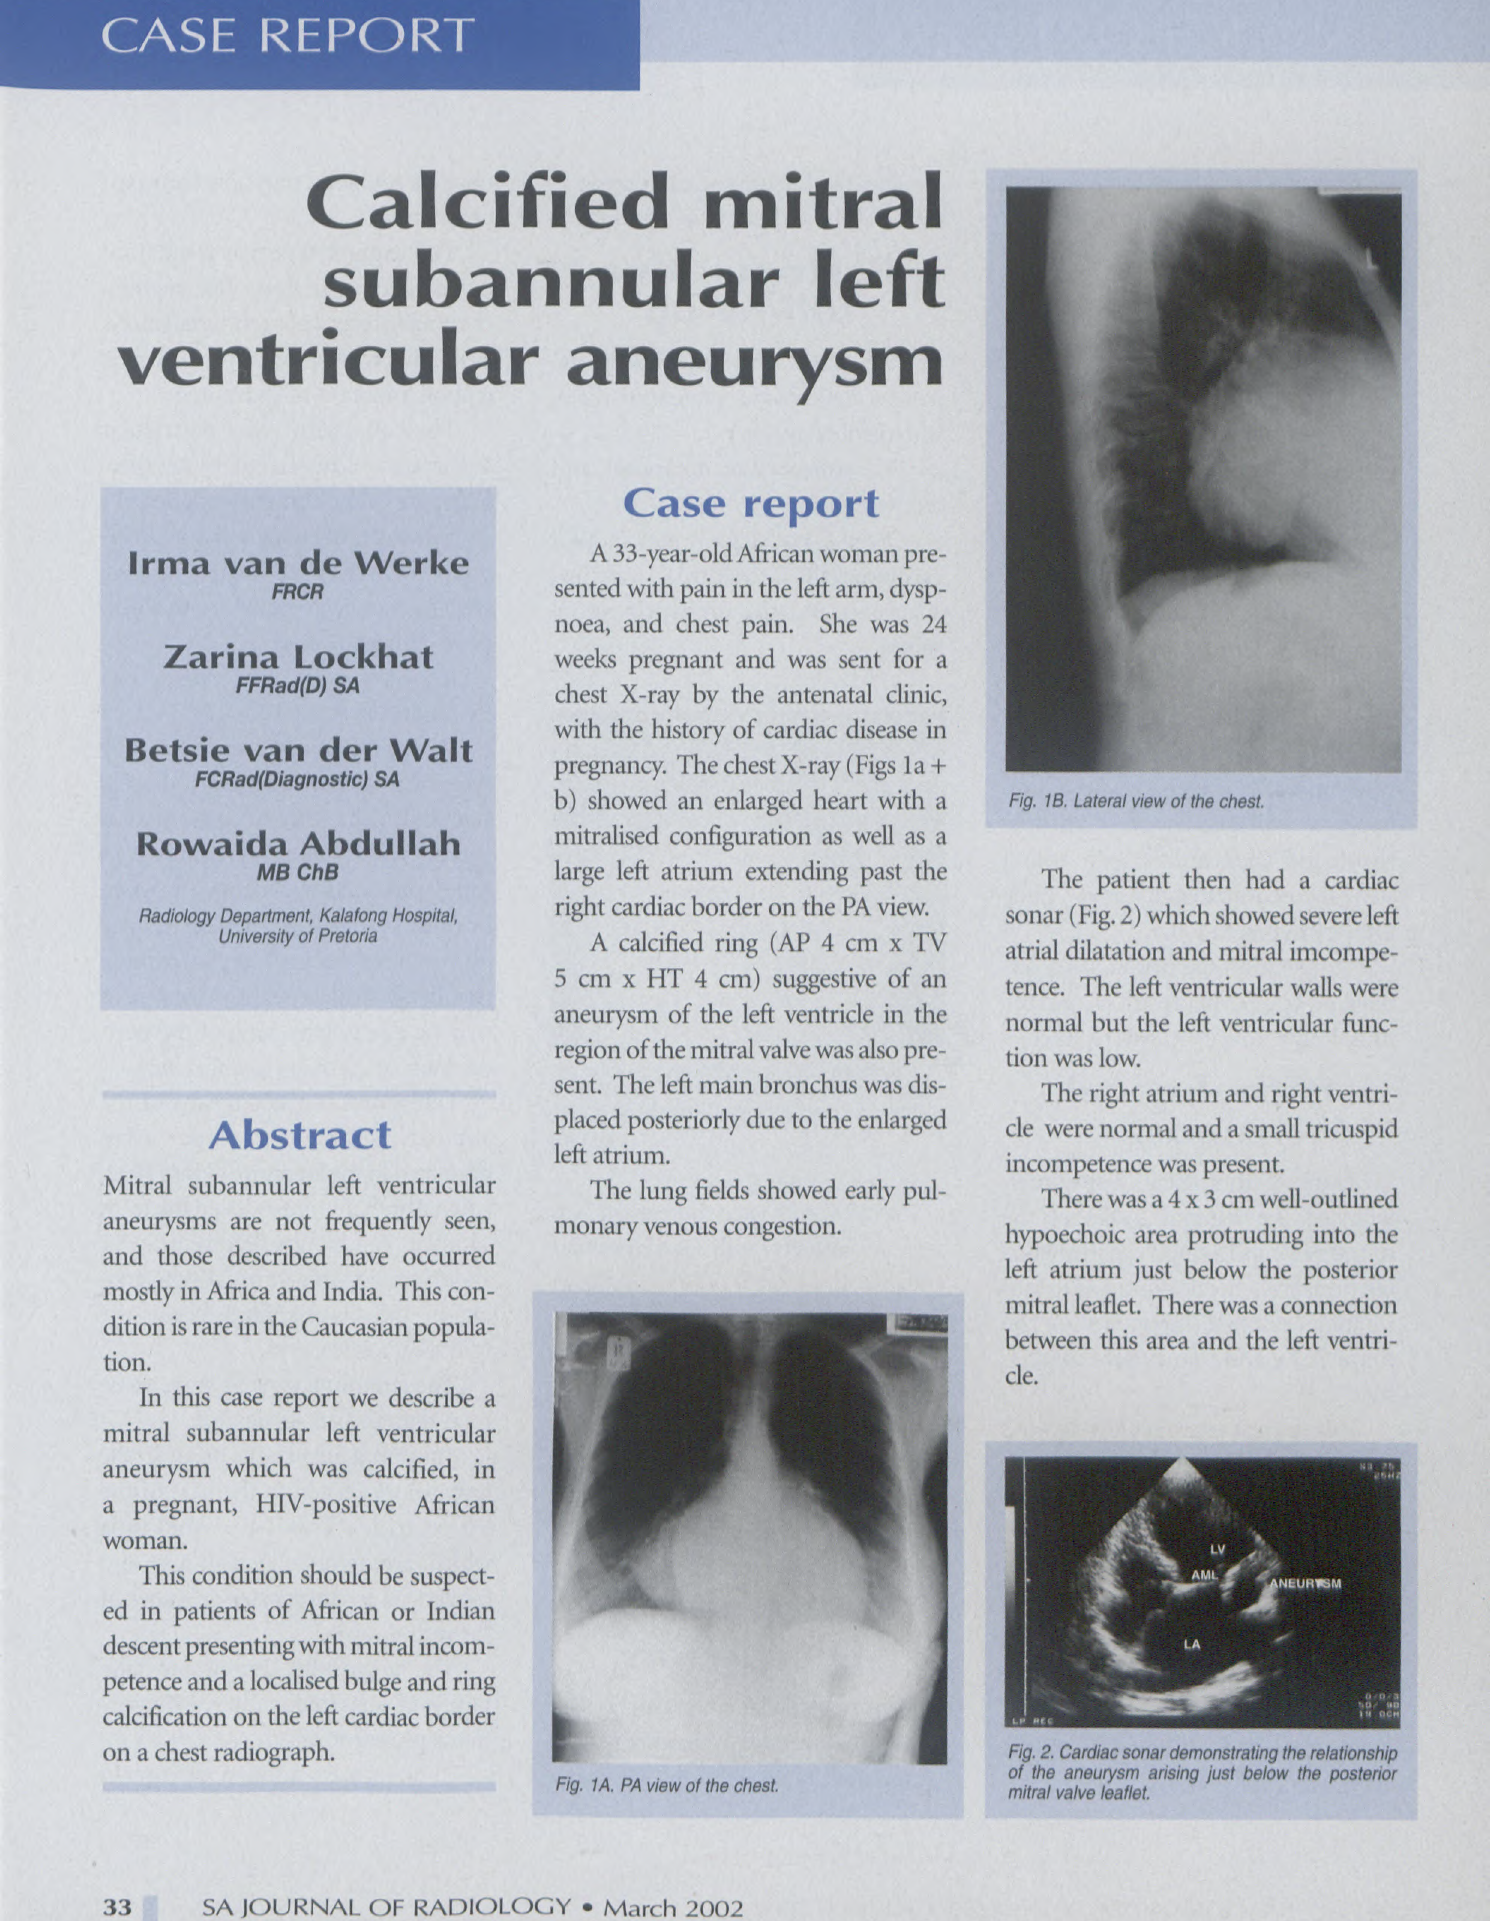
Fig. 2. Cardiac sonar demonstrating the relationship of the aneurysm arising just be/ow the posterior mitral valve